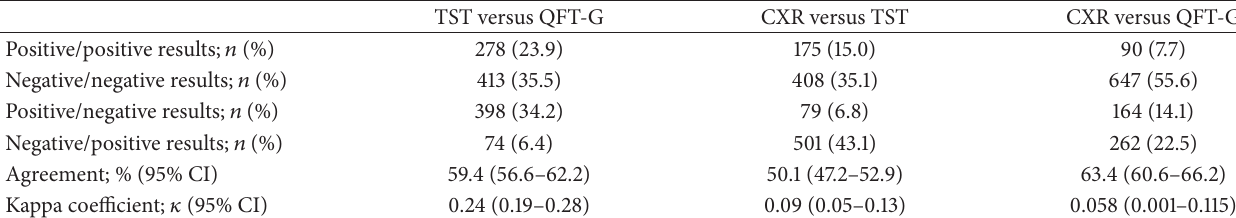
Table 4: Agreement ∗ of TST versus QFT-G, CXR versus TST, and CXR versus QFT-G. TST versus QFT-G CXR versus TST CXR versus